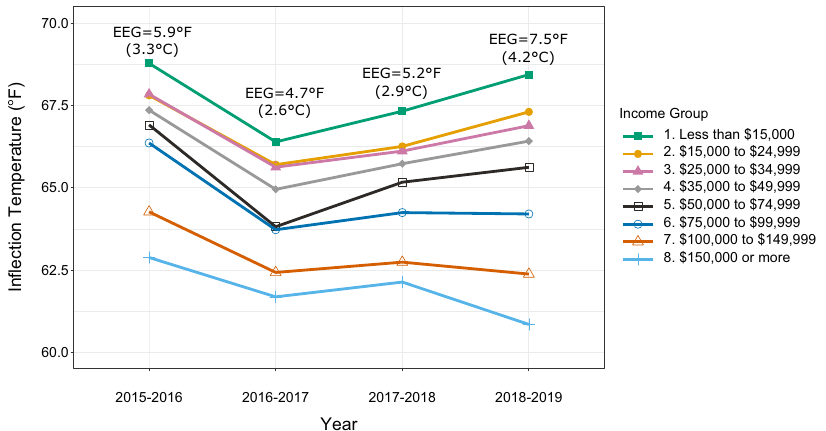
Fig. 4 Energy equity gap (EEG) and median in fl ection temperature changes across study years. Each line represents one income group. Each data point represents the median in fl ection temperature of the income group for that